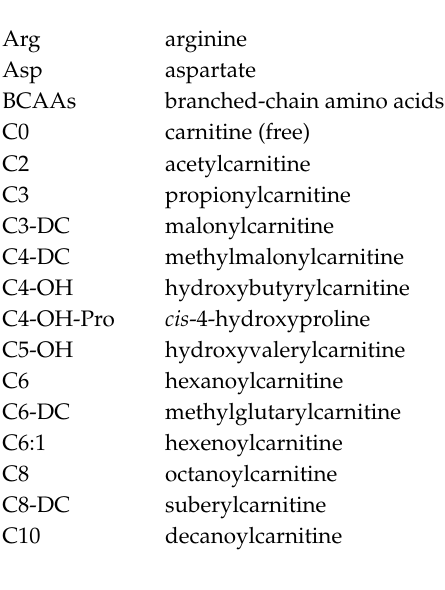
Supplementary Materials: The following are available online, Table S1: Values of metabolites analyzed in the experiment; Table S2: Abbreviations of metabolites